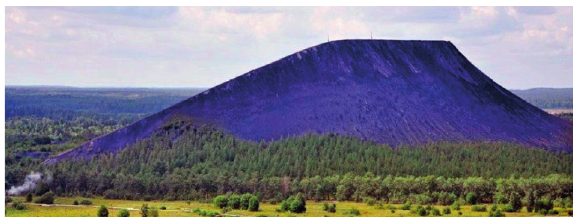
Fig. 1. Kiviõli semi-coke hill in original shape before the flattening, view from East (photo was taken in August 2009, Lempzi pildiblog 2014)